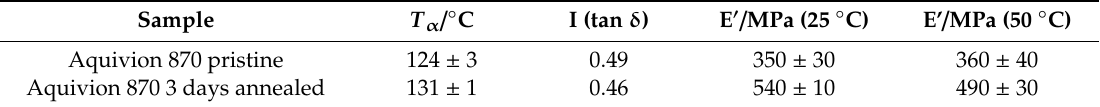
Table 1. Ionomer relaxation temperatures T α ( ◦ C), maximum damping intensity I (tan δ ) and storage